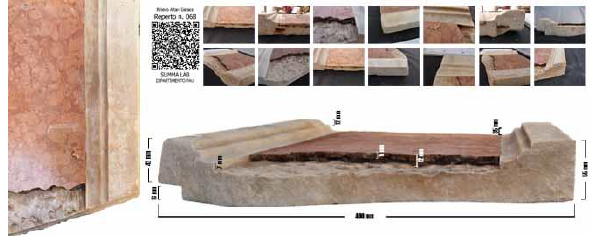
Figure 5. Dimensioned 3D model of a